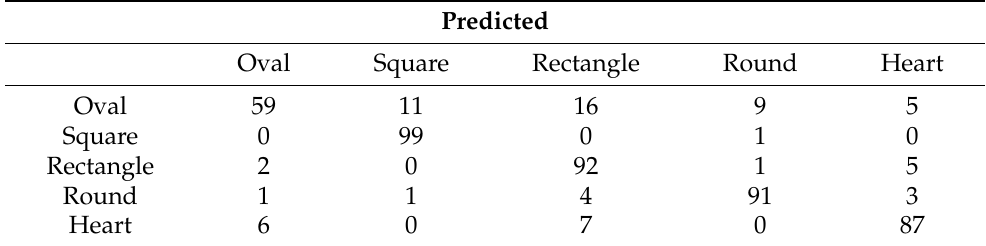
Table 1. Confusion matrix representing the five classes of face shape.